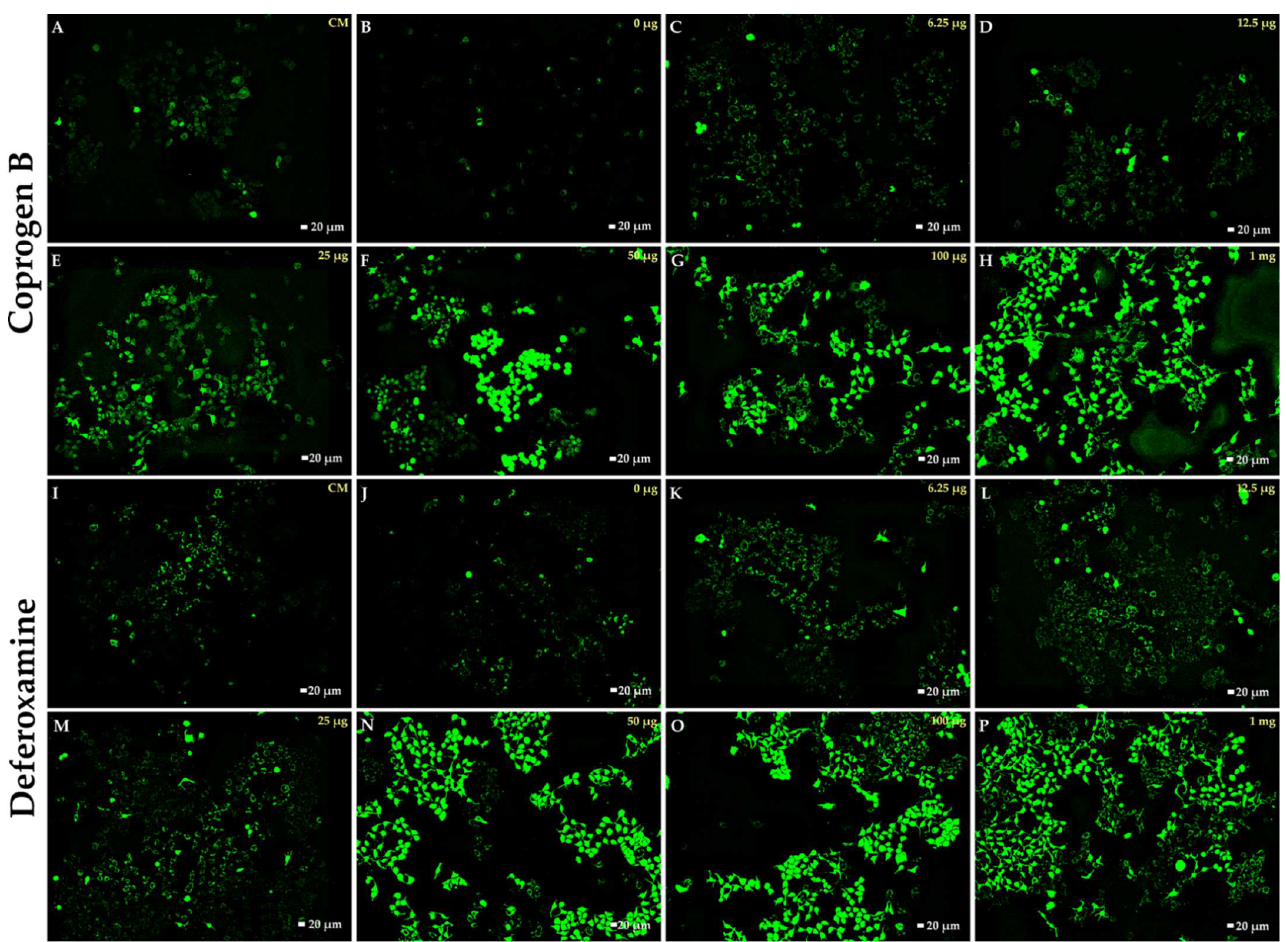
Figure 9. Effect of Coprogen B and deferoxamine on labile iron pool levels in iron-loaded human hepatocellular carcinoma (Huh7) cells. The ferric ammonium citrate was loaded into Huh7 cells to produce iron-loaded cells. The iron-loaded Huh7 cells were stained with 0.2 µM calcein-AM. After that the iron-loaded cells were treated with various concentration (0, 0.00625, 0.0125, 0.025, 0.05, 0.1, and 1 mg) of coprogen B ( B – H ) and deferoxamine ( J – P ). The green fluorescence intensity in the cytosol of Huh7 cells was observed by fluorescence microscopy (10×). The upper panel represents the cell treated with purified coprogen B. The lower panel represents the cell treated with deferoxamine. The CM ( A , I ) represents the cell did not load the iron and was treated either with coprogen B or deferoxamine.